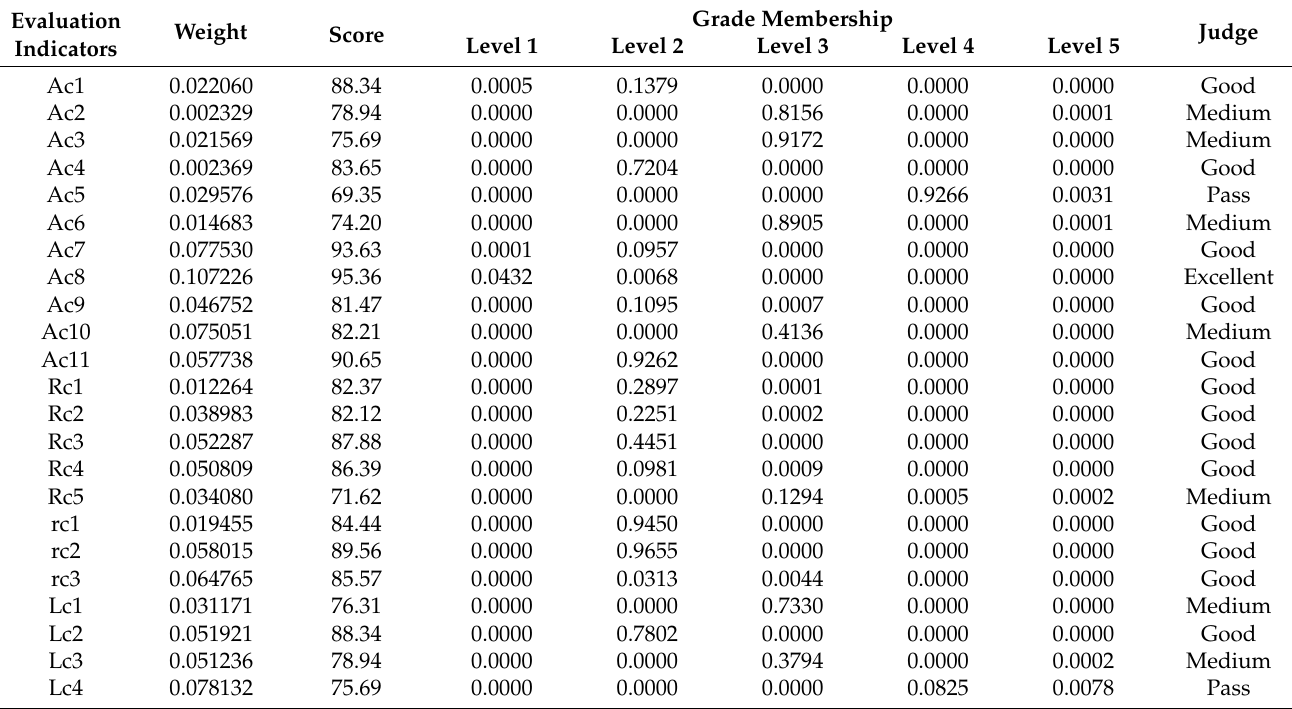
Table 8. Secondary index grade membership degree of resilience evaluation of deep foundation pit construction safety system.